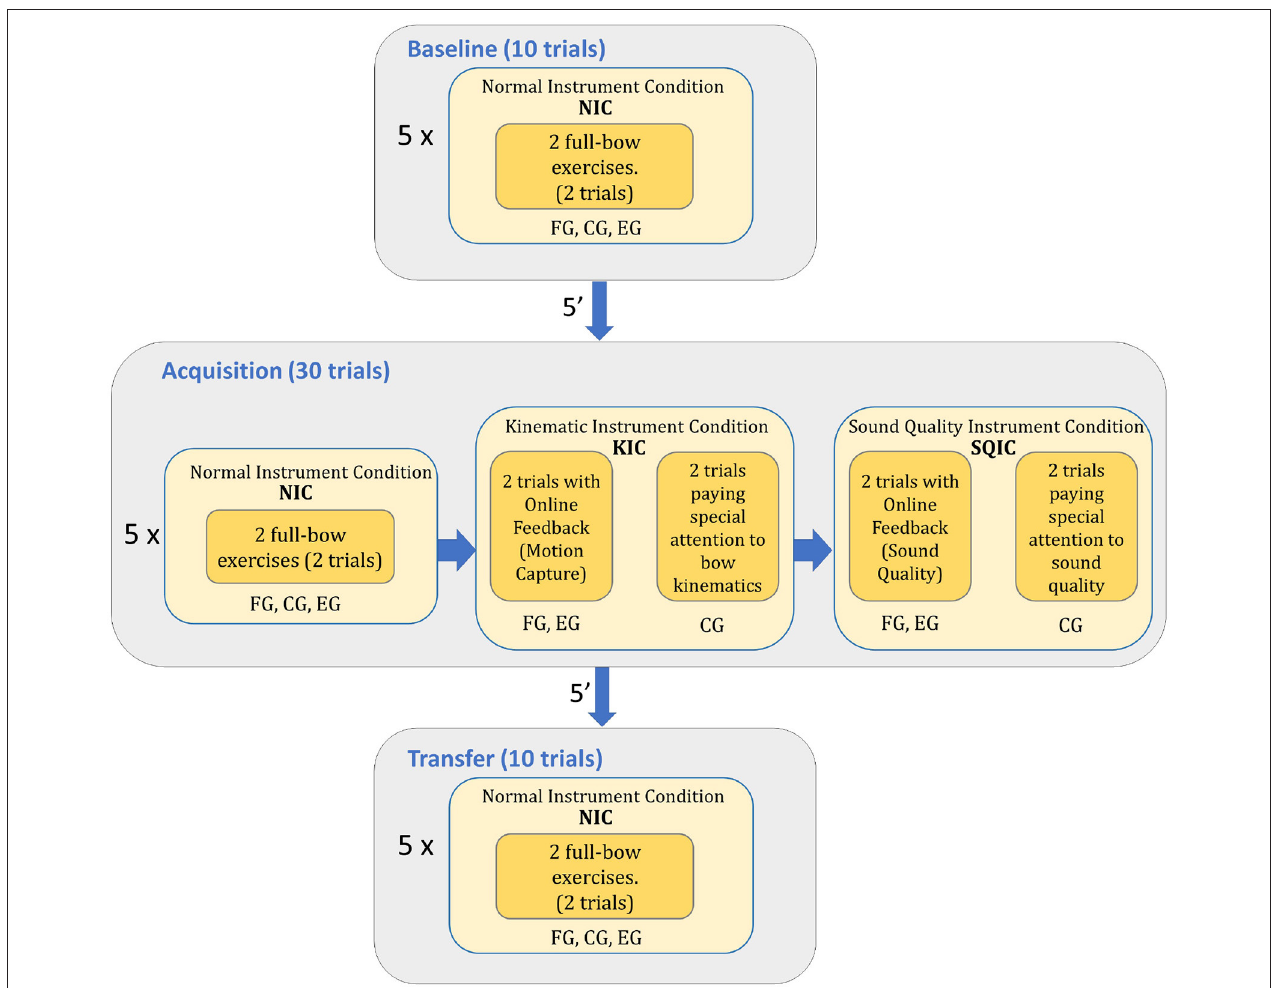
FIGURE 1 | Diagram with the different blocks of the experiment and the different conditions each group of participants went